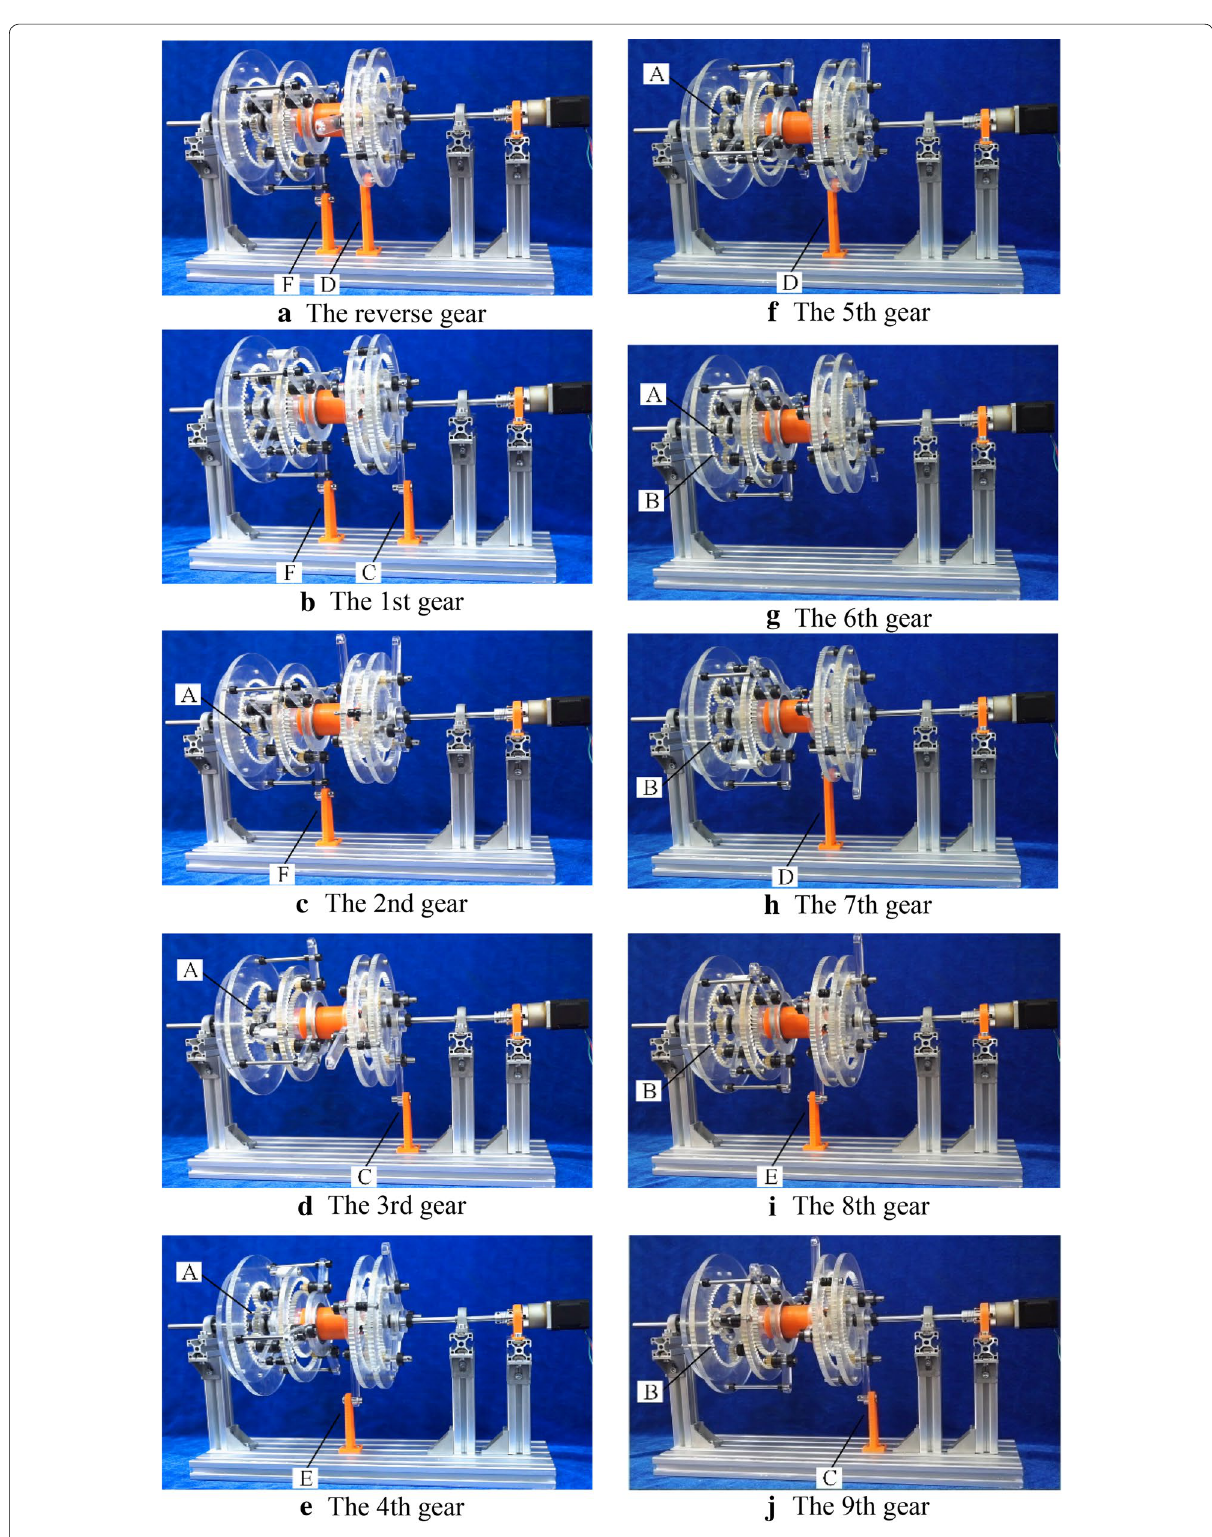
Figure 22 Working conditions of the prototype under each